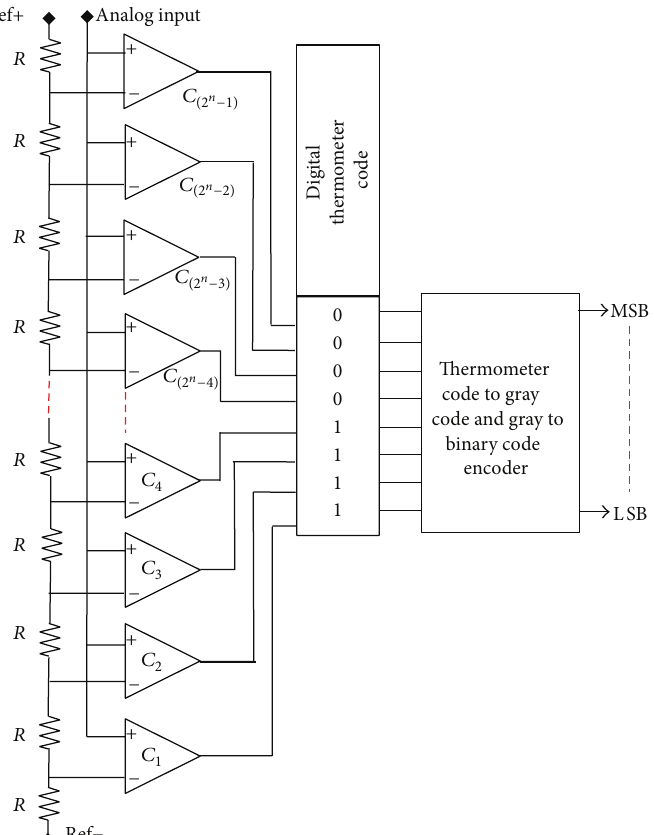
Figure 1: Block diagram of flash analogue-to-digital converter.